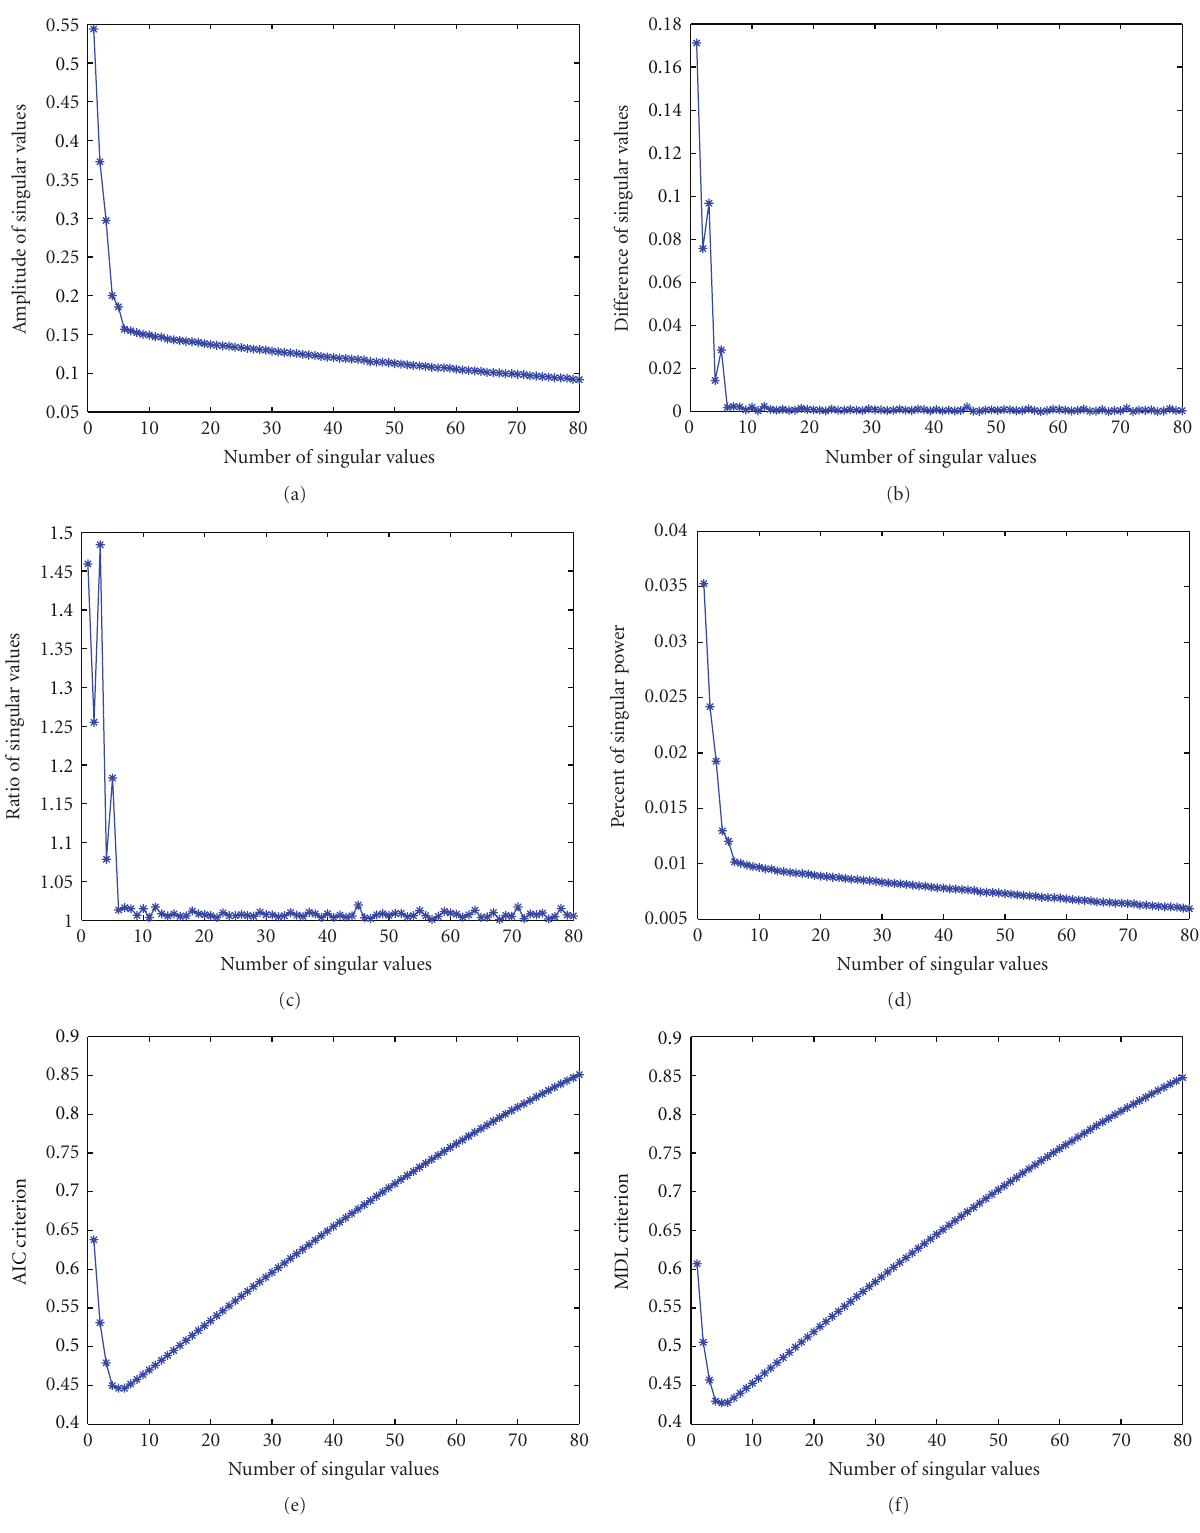
Figure 10: Example 2: Multiple (three) targets (a) amplitude of singular values ( s m ), (b) di ff erence of singular values ( s m − s m +1 ), (c) ratio of singular values ( s m /s m +1 ), (d) power in singular values ( s m / tr[ X ]), (e) AIC function of singular values (10), and (f) MDL function of singular values